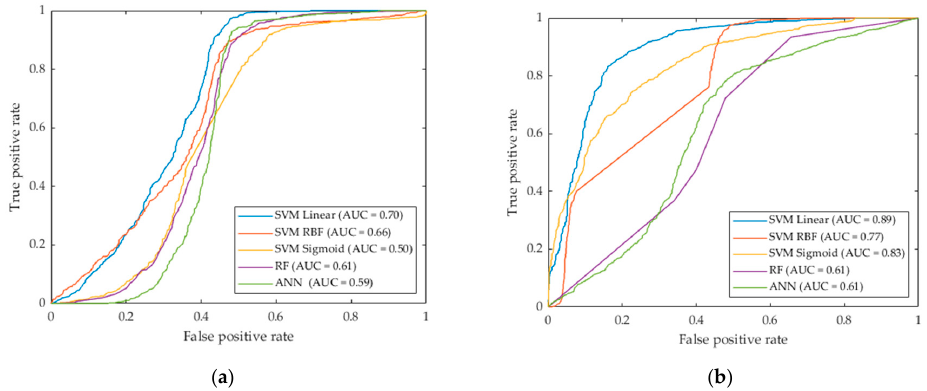
Figure 15. ROC curves for validation classification results obtained with the five classifiers. ( a ) Classification results with default parameters. ( b ) Classification results with optimized hyperparameters.